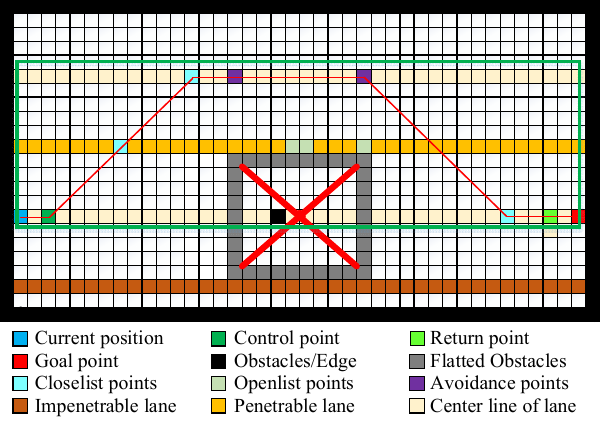
Figure 11. Detection of collision car and avoidance points.